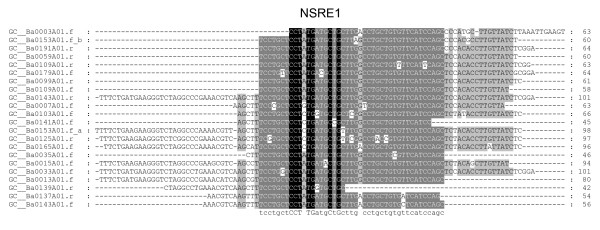
NSRE1 analyses. NSRE1 core nucleotide sequences were aligned using ClustalW. GC_Ba0153A01.f sequence contains two NSRE1 elements (marked as a and b). Shaded color correlates the degree of nucleotide conservation (e.g. black; identical in all sequence). Consensus sequences are shown under the alignment in lower cases.